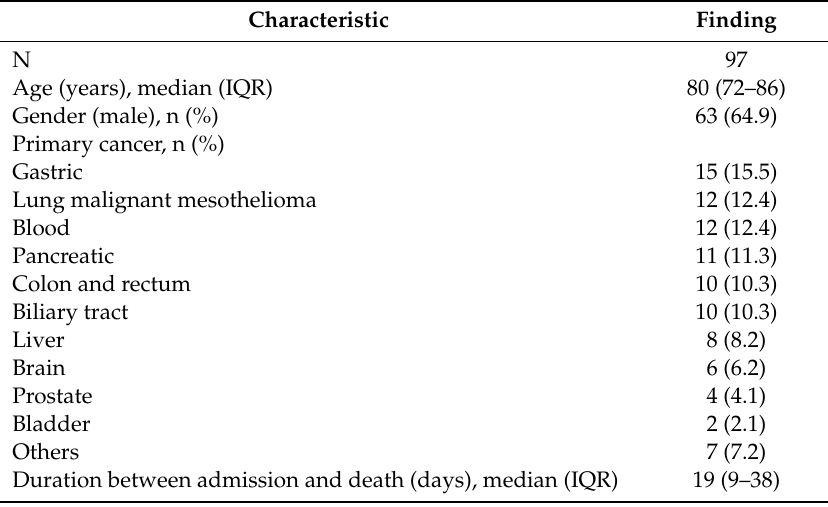
Table 1. Baseline characteristics of the study population.